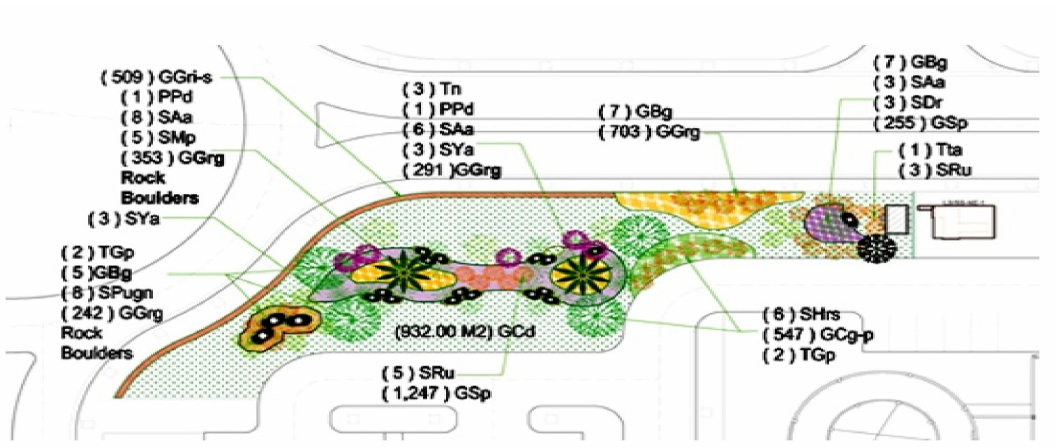
Figure 5. The previous situation for Parking 14 landscape area. Previous tender softscape design (Details of water consumption is shown in Table A1).